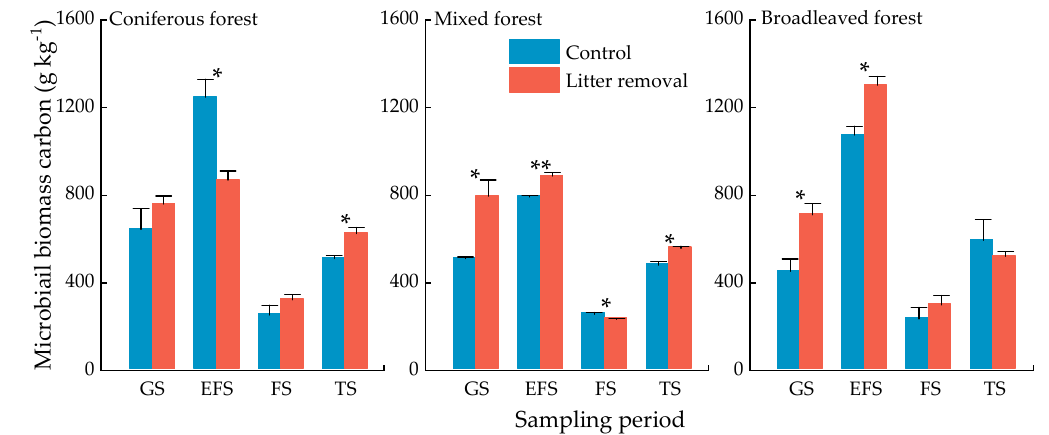
Figure 3. Concentrations of soil microbial biomass C of three forests at different sampling periods. Values indicate means ± standard error, n = 3. Asterisks indicate significant differences between the two treatments in the same forest type at the same season. * p < 0.05, ** p < 0.01. GS: growing season, EFS: early freezing season, FS: freezing season, TS: thawing season. Table 4. Results of three-way RANOVA showing the p -values concerning the effects of sampling time (T), forest type (F), litter treatment (L), and their interactions on soil organic carbon